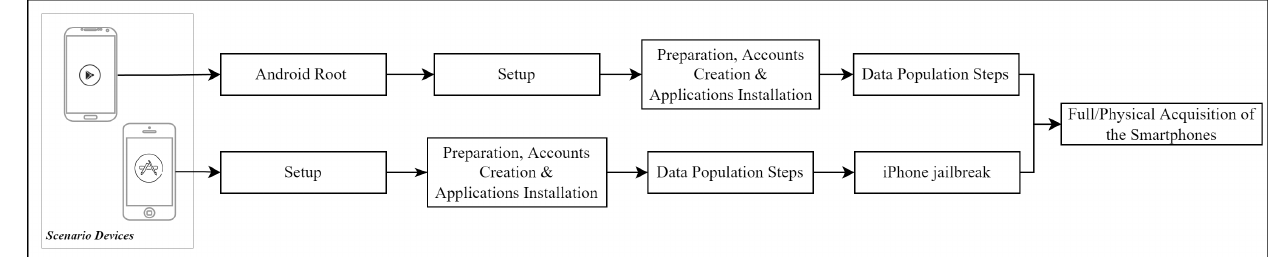
Figure 5. High level procedures order for rooting and jailbrarking the devices.